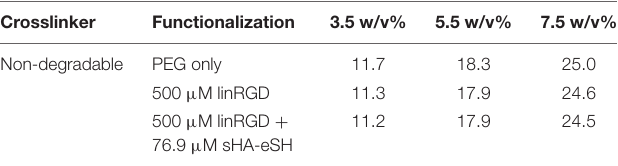
TABLE 1 | Crosslinker concentrations (in mM) for non-degradable hydrogels.